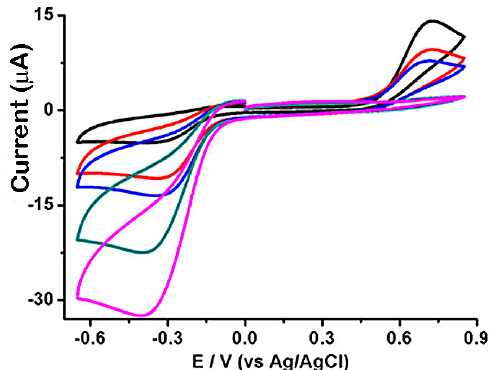
Figure 5. Cyclic voltammograms recorded with the TGNEE incubated with different concentrations of anti-tTG (0, 0.005, 0.01, 0.1, and 1 µg mL − 1 ); other conditions as in Figure 1A.